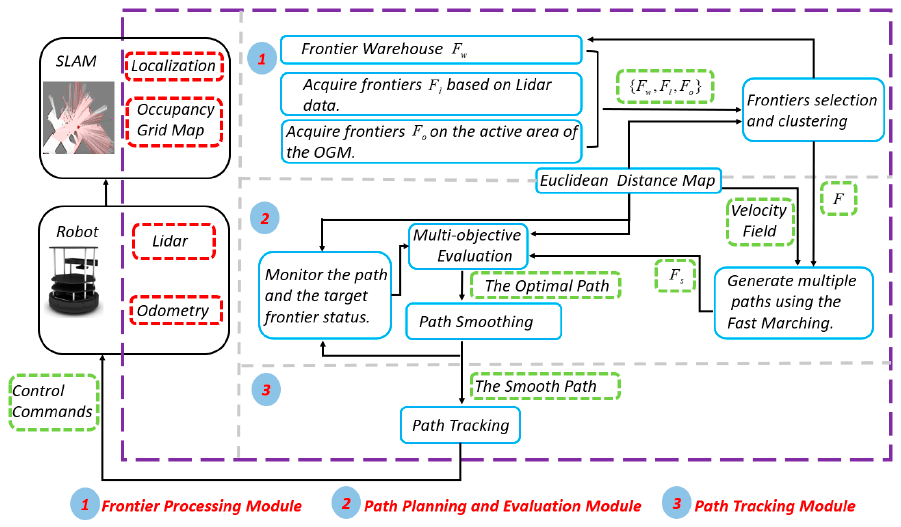
Figure 1. The system architecture of the proposed autonomous exploration framework.